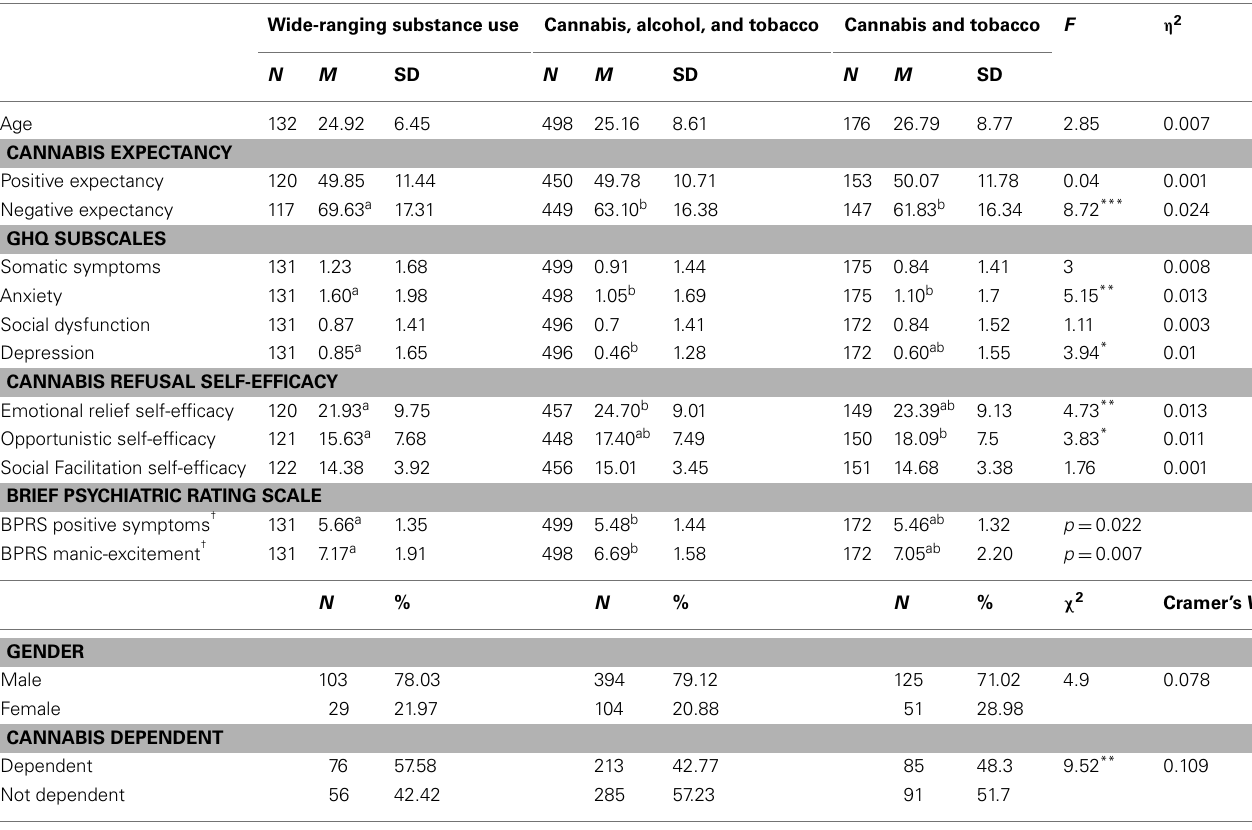
Table 3 | Profile of the three substance use